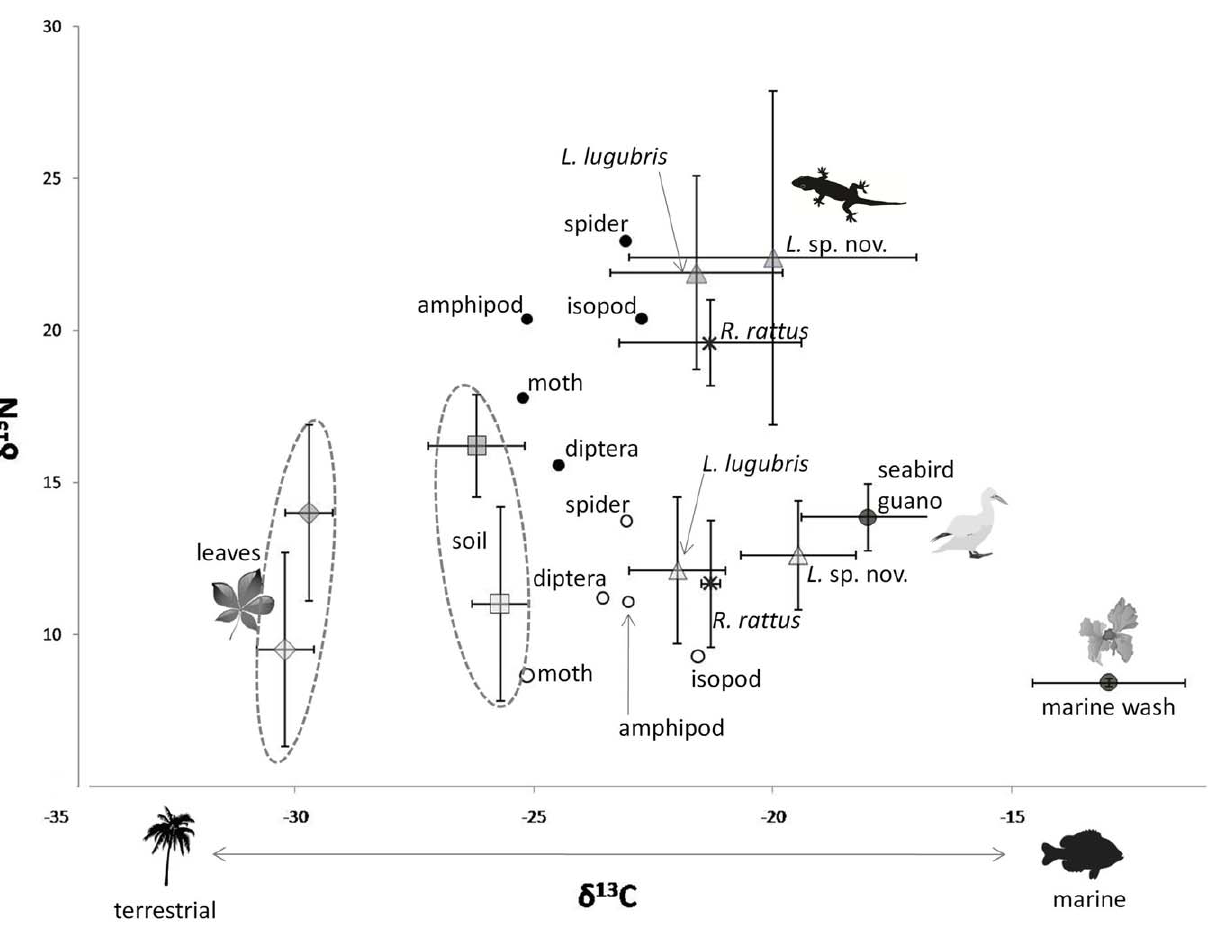
Figure 1. Differences in leaf, soil, and gecko (both Lepidodactyluslugubris and Lepidodactylus sp. nov.) stable isotope values (means ± 1 SD) measured in dicot forests (grey and black symbols) and palm forests (open symbols). Tissues from R. rattus in both forest types are shown as a reference (denoted with a *). Prey items (small circles) are shown without SD for visual clarity (SD values are included in Table S1). Significantly enriched d 15 N values in dicot forests suggest allochthonous subsidies from seabird guano are incorporated in all organisms. Extreme elevation of d 15 N of both gecko species suggests changes in diet of these species across forest types, or larger changes in food web. Values of d 13 C in geckos suggest allochthonous marine food sources are important in diets of both gecko species, but are significantly more important for L. sp. nov.